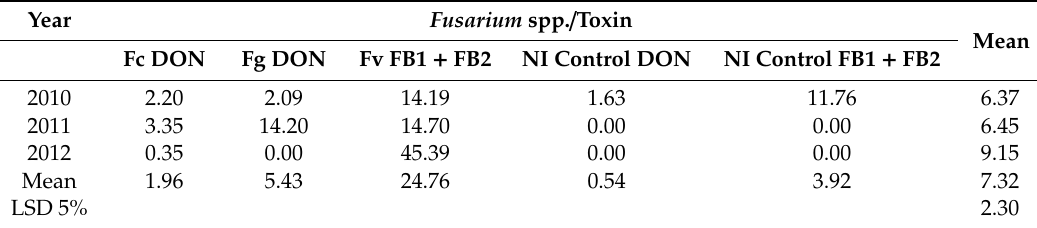
Table 15. Toxin contamination of the grains of ten selected maize hybrids following toothpick inoculation in di ff erent years against Fusarium spp. and control, Szeged,